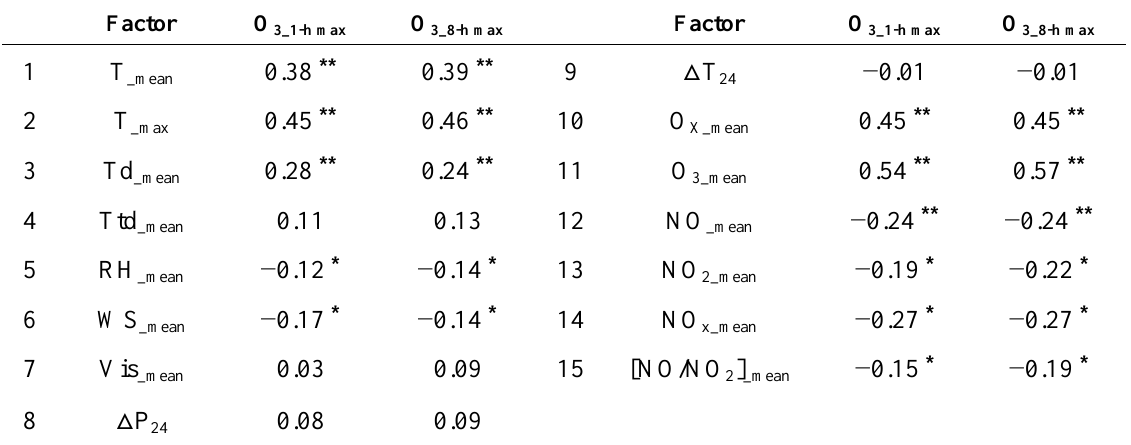
Table 3. Coefficients of correlation between 15 factors and O